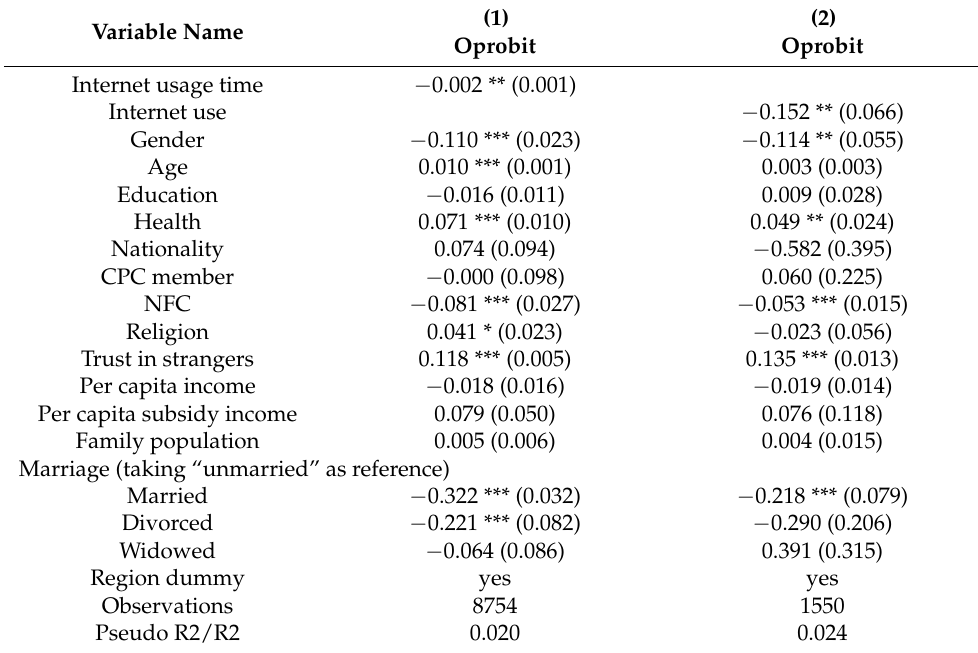
Table 5. Results for changing variables and